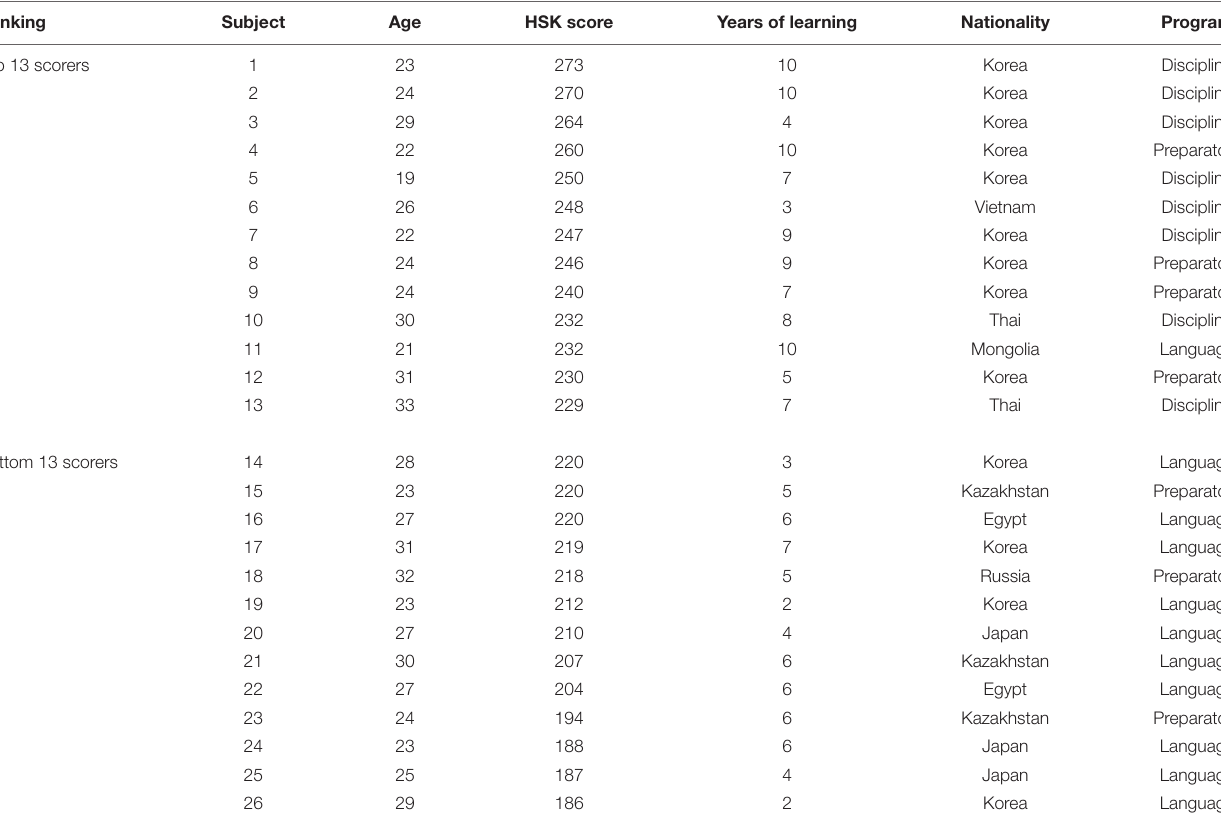
TABLE 1 | Background information of L2